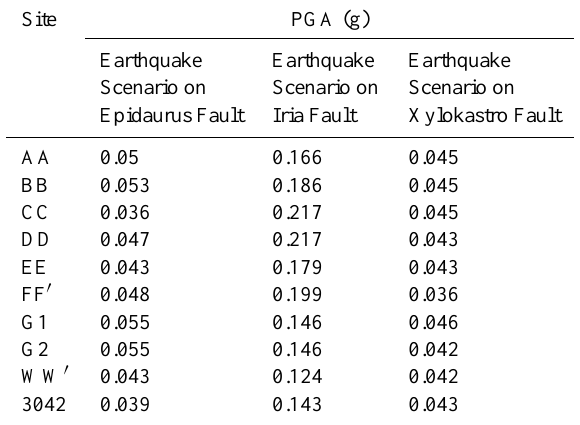
Table 2. PGA values at the horizontal component of ground mo- tion as computed stochastically for each one of the three examined earthquake scenarios and each examined